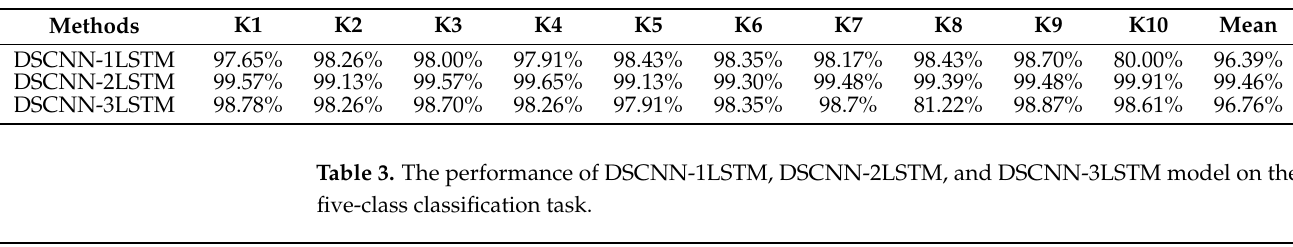
Table 2. The performance of DSCNN-1LSTM, DSCNN-2LSTM, and DSCNN-3LSTM model on the binary classification task.